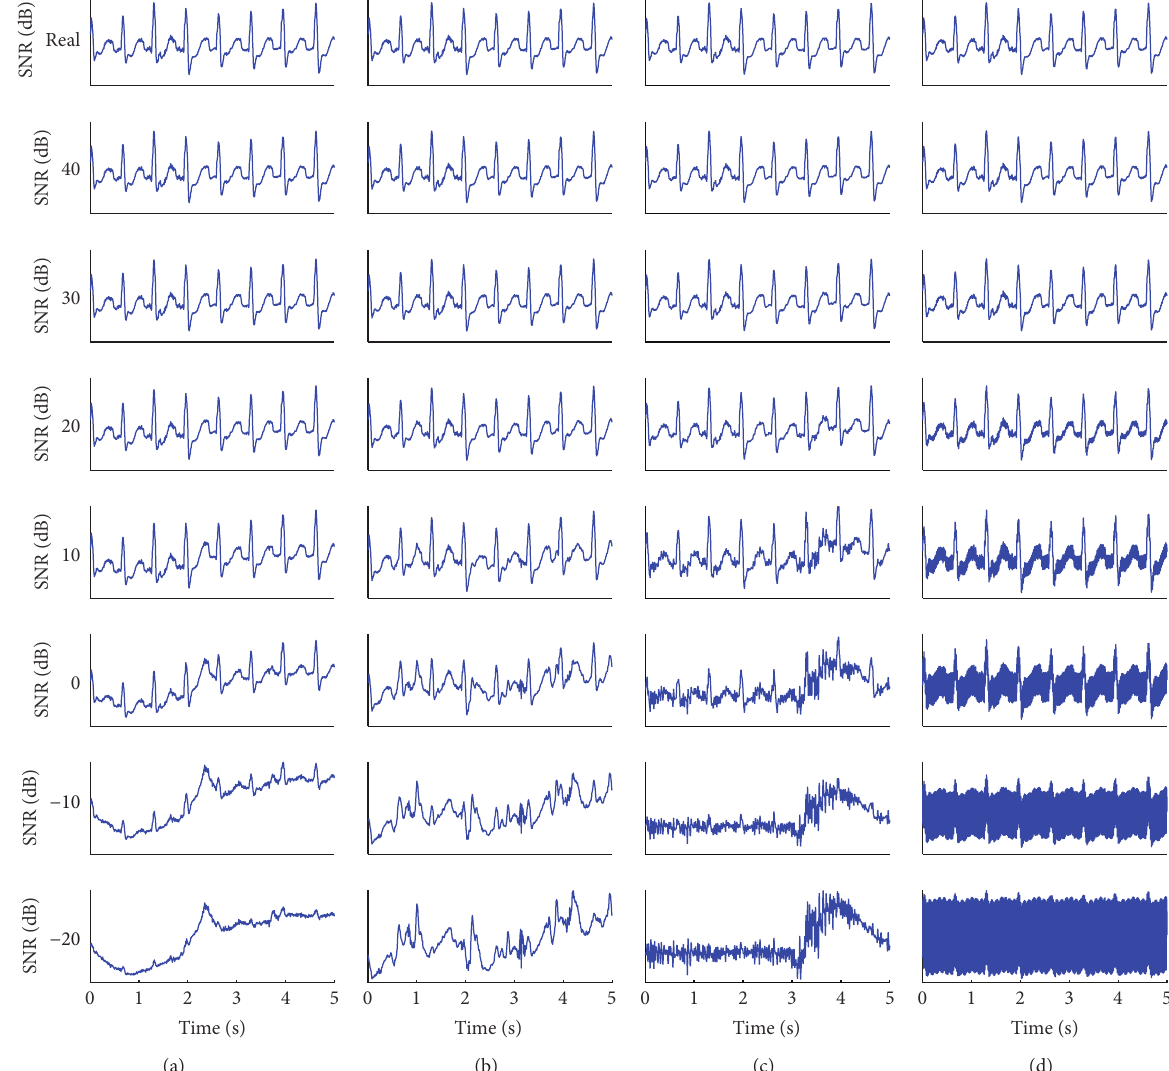
Figure 2: The real ECG and real ECG added noises with different SNRs from − 20dB to 40 dB, with a step of 10dB. (a) The real ECG and the real plus BW. (b) The real ECG and the real plus EM. (c) The real ECG and the real plus MA. (d) The real ECG and the real plus PL noise.